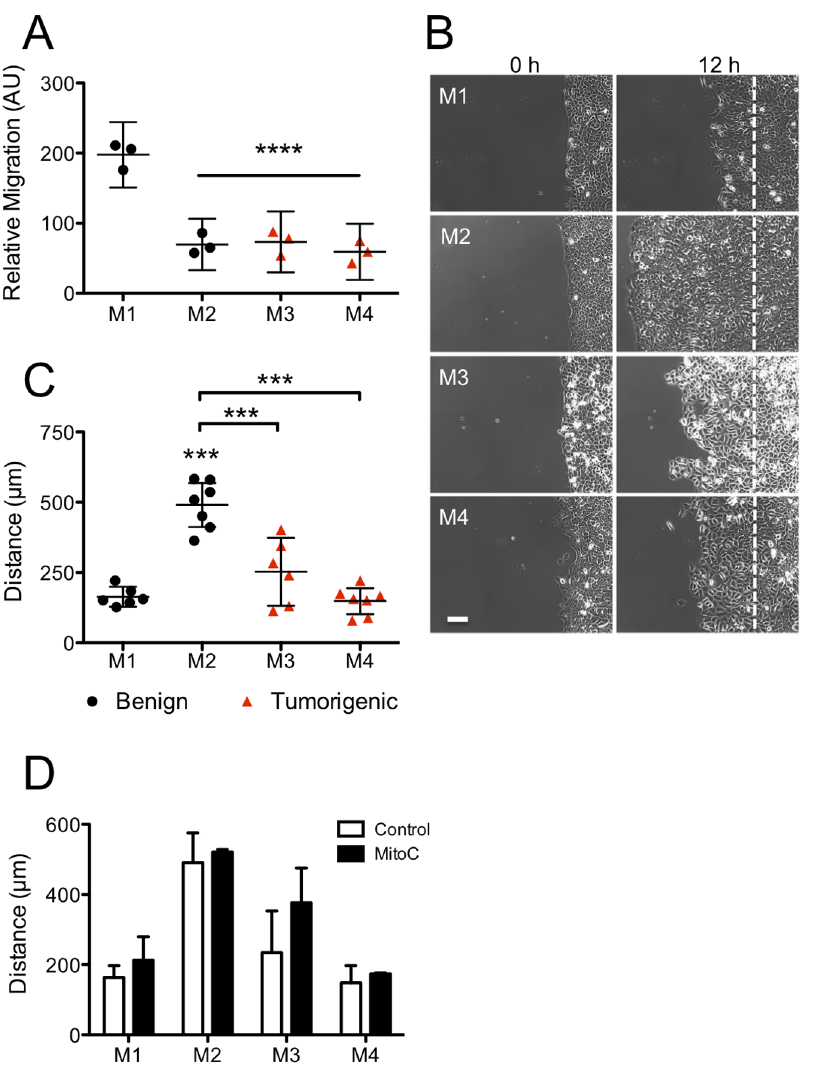
Figure 1. Cell lines of the MCF10A series show distinct migration properties. ( A ) Migration potential of M1–M2 (benign, black circles) and M3–M4 (tumorigenic, red triangles) cell lines after 4 h was assessed with the transwell assay using collagen IV coated membranes and no biased stimulation (see also Fig. S1A). ( B ) Phase images of the M1–M4 cell lines after 0 and 12 h of unconstrained migration. The dash vertical line indicates the initial location of the sheet edge. Scale bar =100 m m. ( C ) Quantification of the net displacement (during the 3–12 h time frame) is presented as in panel A. ( D ) M1–M4 cells were first pretreated with 25 m g/mL Mitomycin C for 20 min and then allowed to migrate into open space under conditions identical to panel B (black bars). The net displacement (mean 6 SD) is shown compared to control (w/o drug) conditions (white bars), n=2. For panels A and C results are presented as mean 6 95% CI of 6–7 independent experiments. Statistical significance: * p , 0.05, ** p , 0.01, *** p , 0.001, ****p , 0.0001 (Tukey-Kramer test, n=6–7). All comparisons were made with M1 cells unless indicated by pairing-brackets. (Fig. 2C, right panel). Taken together a comprehensive analysis of cell motility indicates that directionality of cell movement is markedly suppressed in these tumorigenic breast cancer cell lines compared to their benign counterparts.